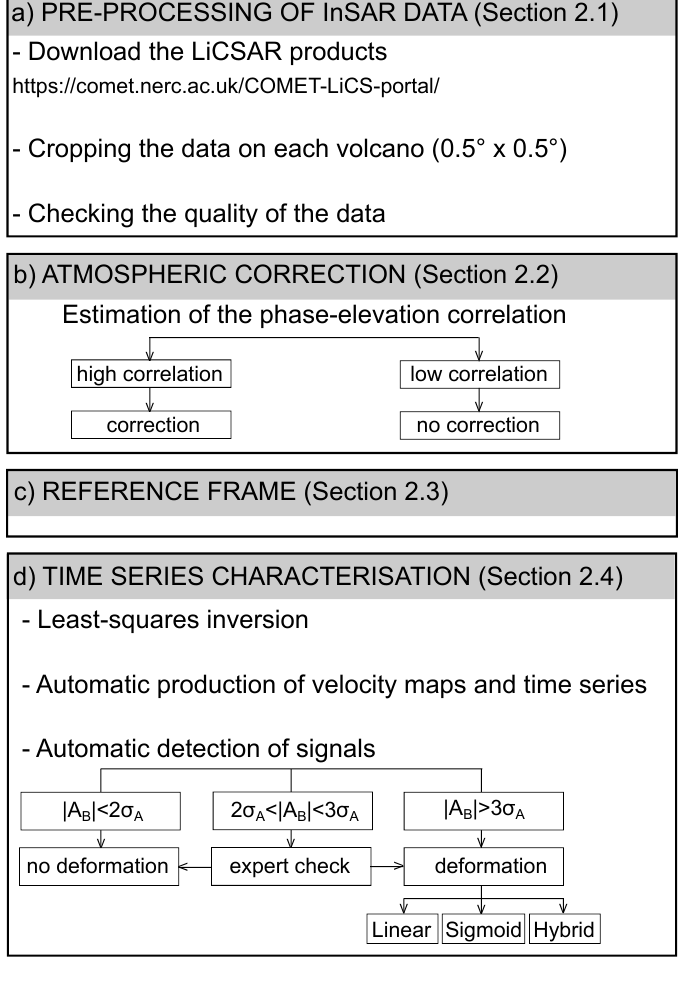
Figure 1. Flowchart showing the important steps for the automatic production and classification of Sentinel-1 time